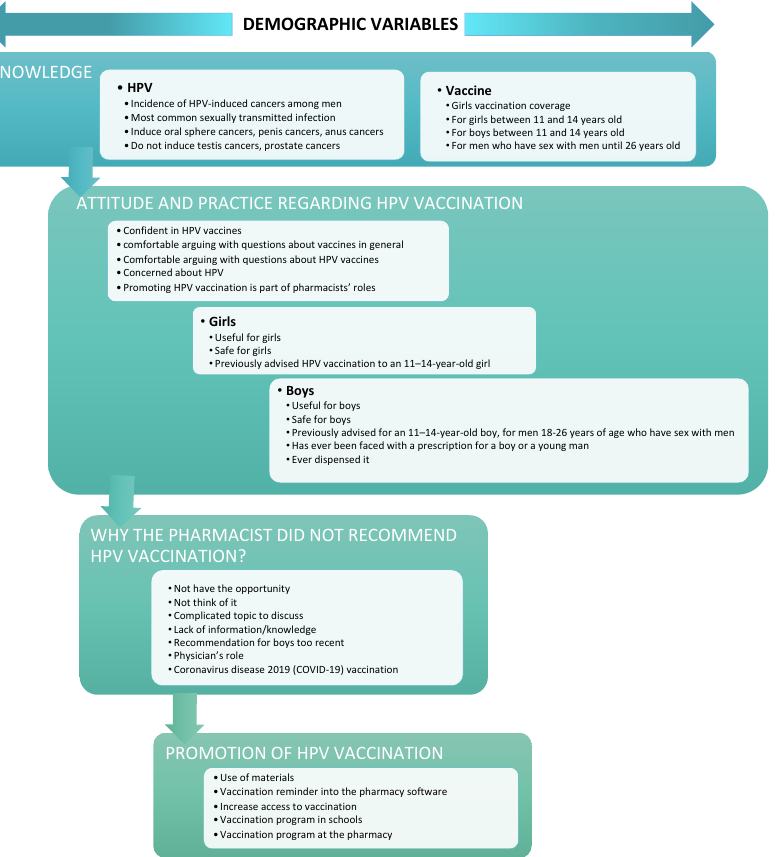
Figure 2. Conceptual framework of knowledge, attitudes, and practices as determinants for the promotion of HPV